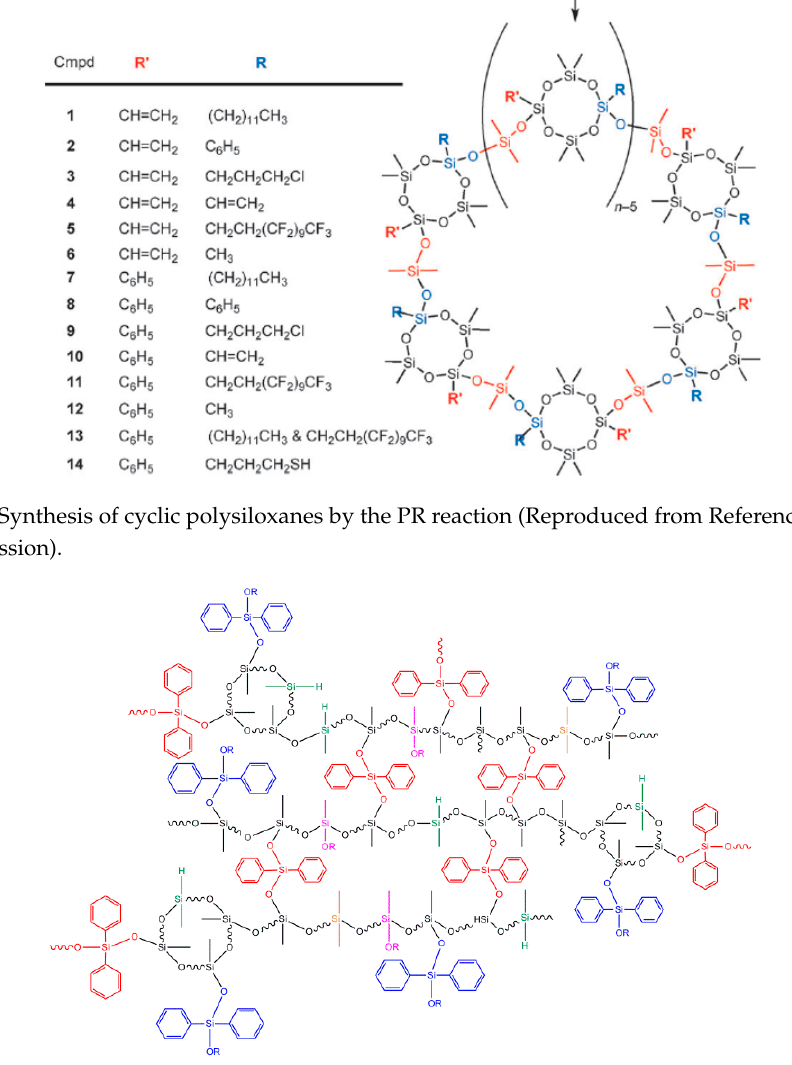
Figure 7. Complex bridge-link-type polysiloxanes (Reproduced from Reference [33]).